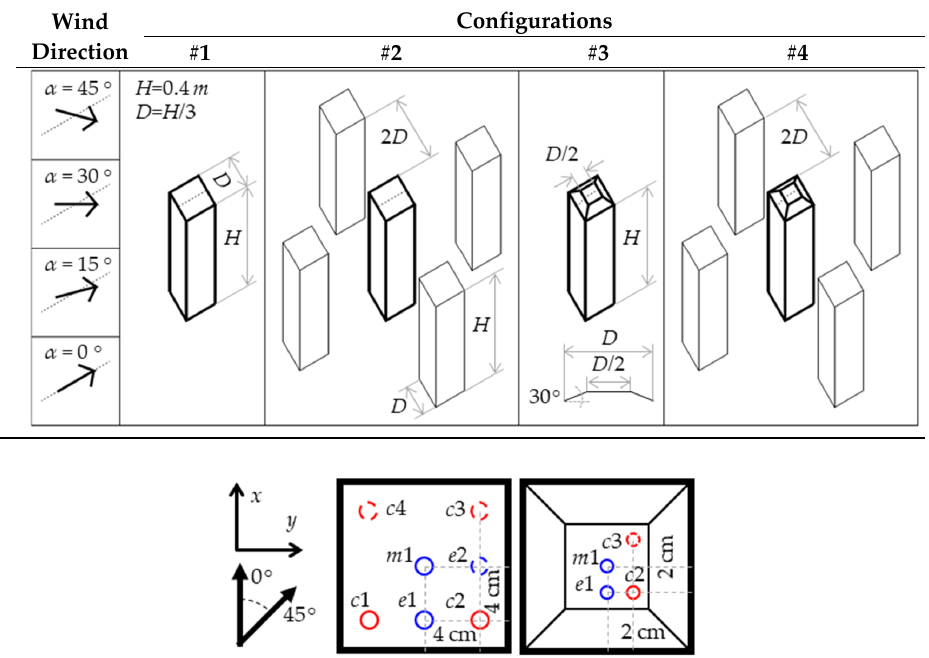
Table 1. High-rise building configurations, with indication of wind direction and main dimensions.